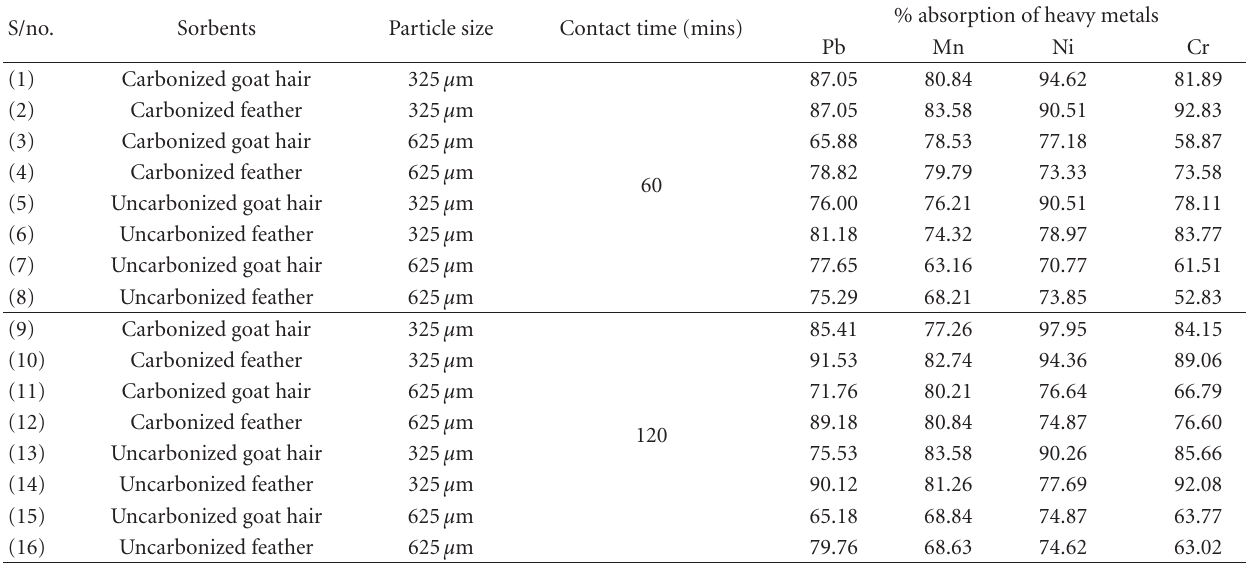
Table 3: Use of carbonized/uncarbonized waste protein sorbents in removal of heavy metals from wastewater. S/no.